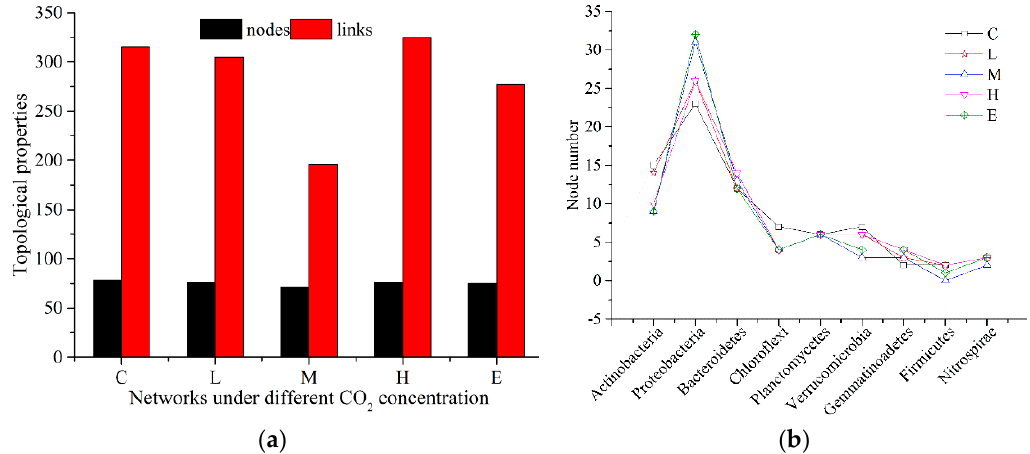
Figure 2. The node and link number for the five networks ( a ), and the node number of each phylum for the five networks ( b ). (C, control; L, low CO 2 concentration; M, medium CO 2 concentration; H, high CO 2 concentration; E, extreme CO 2 concentration).